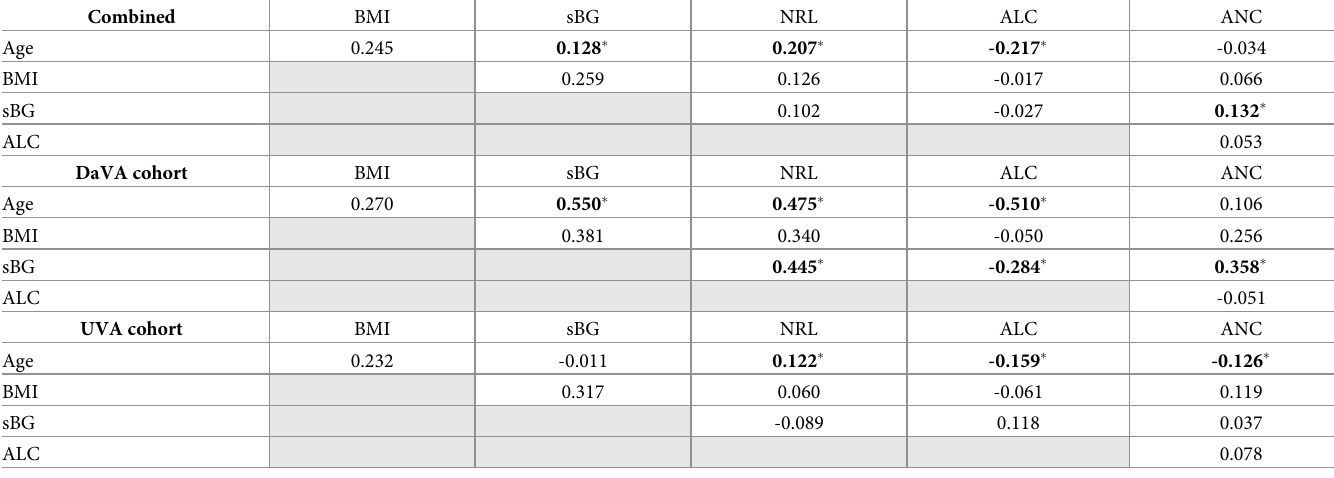
sBG = serum blood glucose; ALC = absolute lymphocyte count; ANC = absolute neutrophil count; NLR = neutrophil lymphocyte ratio � = p-value < 0.05 after correction for multiple comparisons using Bonferroni method